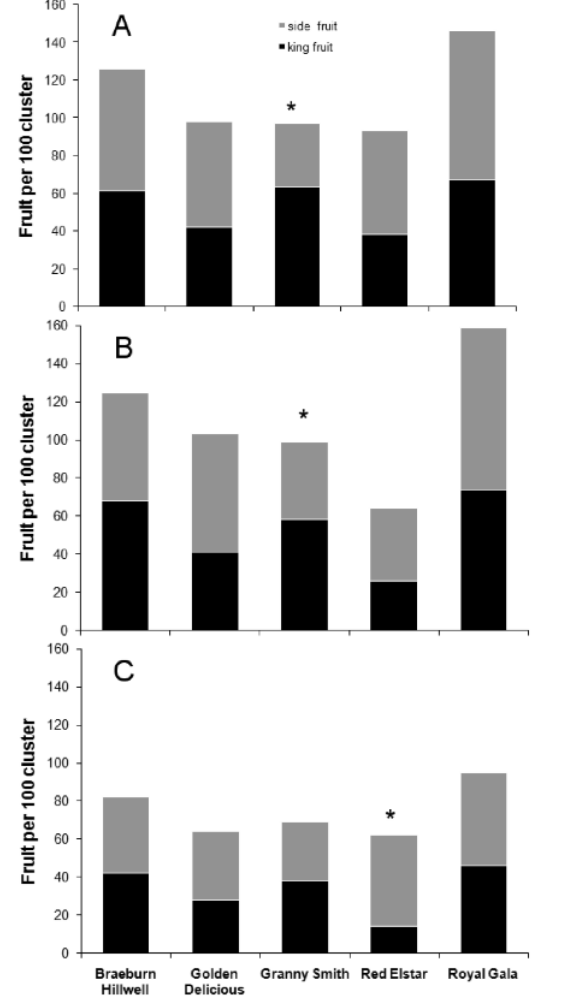
Fig. 4. Distributions of king and side fruits on the clusters of five apple cultivars on M.9 (A), MM.106 (B) and seedling (C) rootstocks at harvest. Data are based on the average of 2006 and 2007. * indicates significant differences in fruit set between king and side